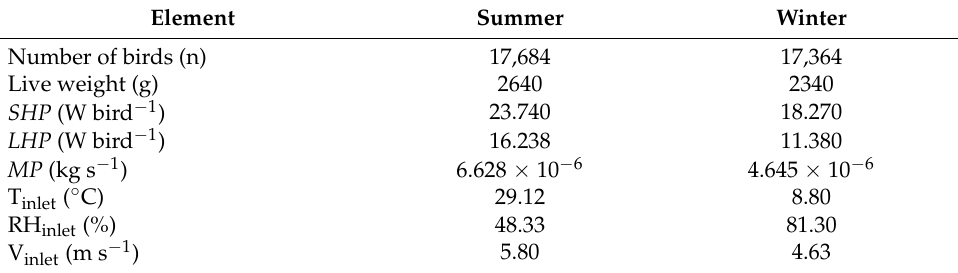
Table 1. Boundary conditions in this